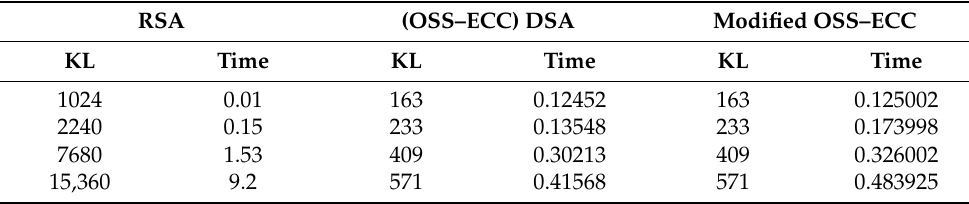
Figure 8. Comparison of total processing time of the proposed scheme and other state-of the- art schemes proposed in [32]. Note that “RSA”, “DSA”, “OSS”, and ““ECC” stand for Rivest, Shamir and Adleman; digital signature algorithm, Ong, Schnorr, and Shamir; and elliptic curve cryptography, respectively. Table 2. Signature generation computational cost (in milliseconds) of different signature schemes and the proposed scheme. Note that “RSA”, “DSA”, “OSS”, and ““ECC” stand for Rivest, Shamir and Adleman; digital signature algorithm, Ong, Schnorr, and Shamir; and elliptic curve cryptogra- phy, respectively.